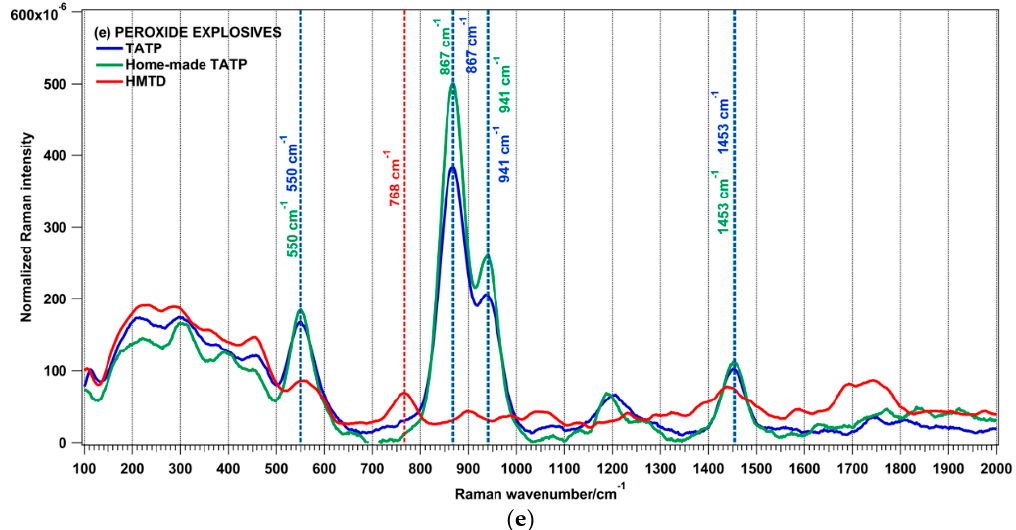
Figure 6. Normalized reference spectra of energetic materials: Nitramines ( a ); Nitrate esters ( b ); Salts and azides ( c ); Nitroarenes ( d ); Peroxides ( e ). Spectra acquired using the 266-nm wavelength for the excitation (pulse length = 10 ns, wavelength = 266 nm, radiant exposure = 3 mJ/cm 2 , exposure time = 0.0011 s).